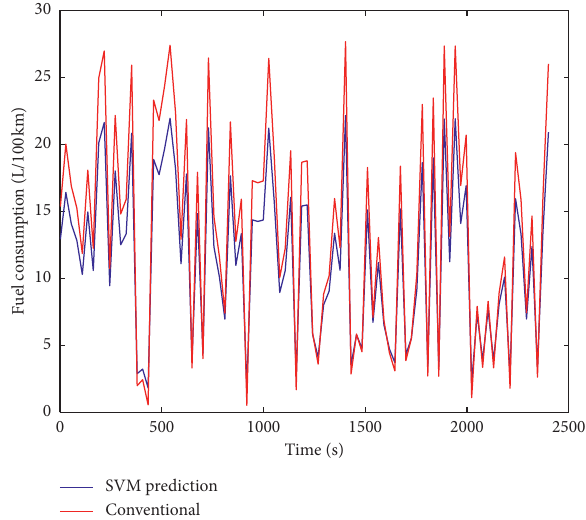
Figure 7: Proposed SVM prediction model vs. conventional